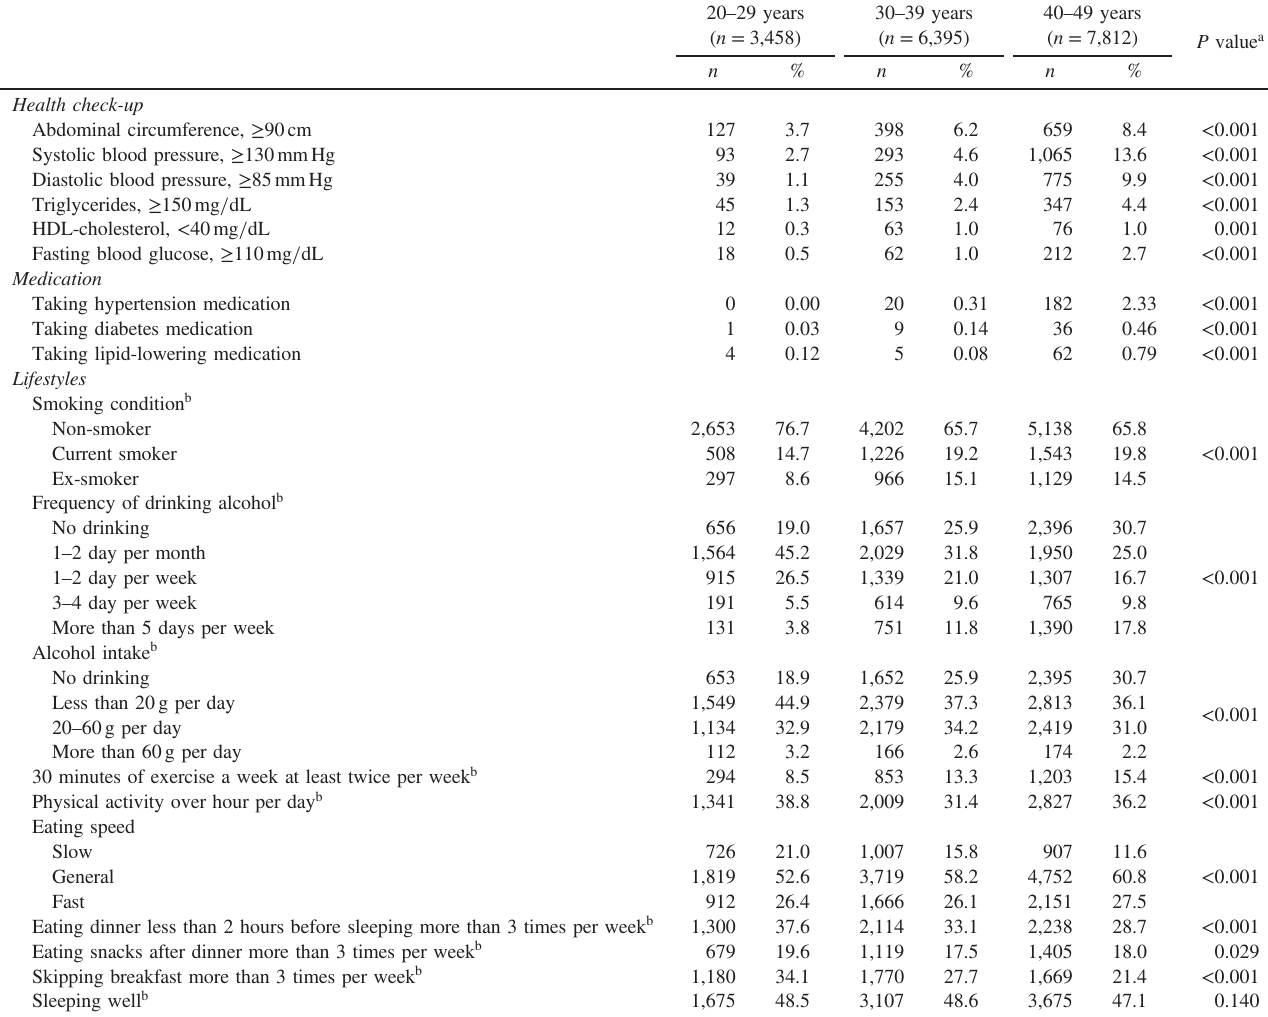
Table 1. Characteristics of women participants at